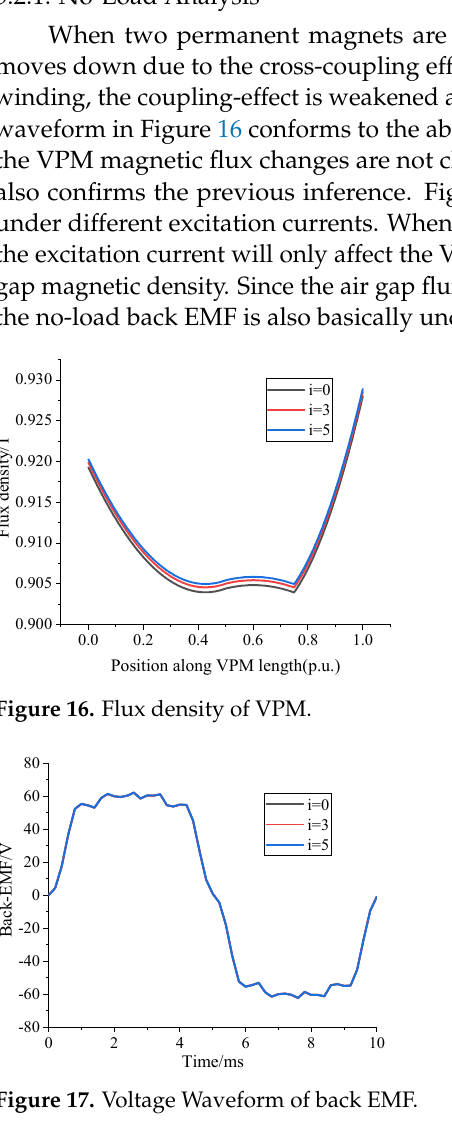
( b ) Figure 15. Motor output torque. ( a ) Output torque with the forward parallel permanent magnet;